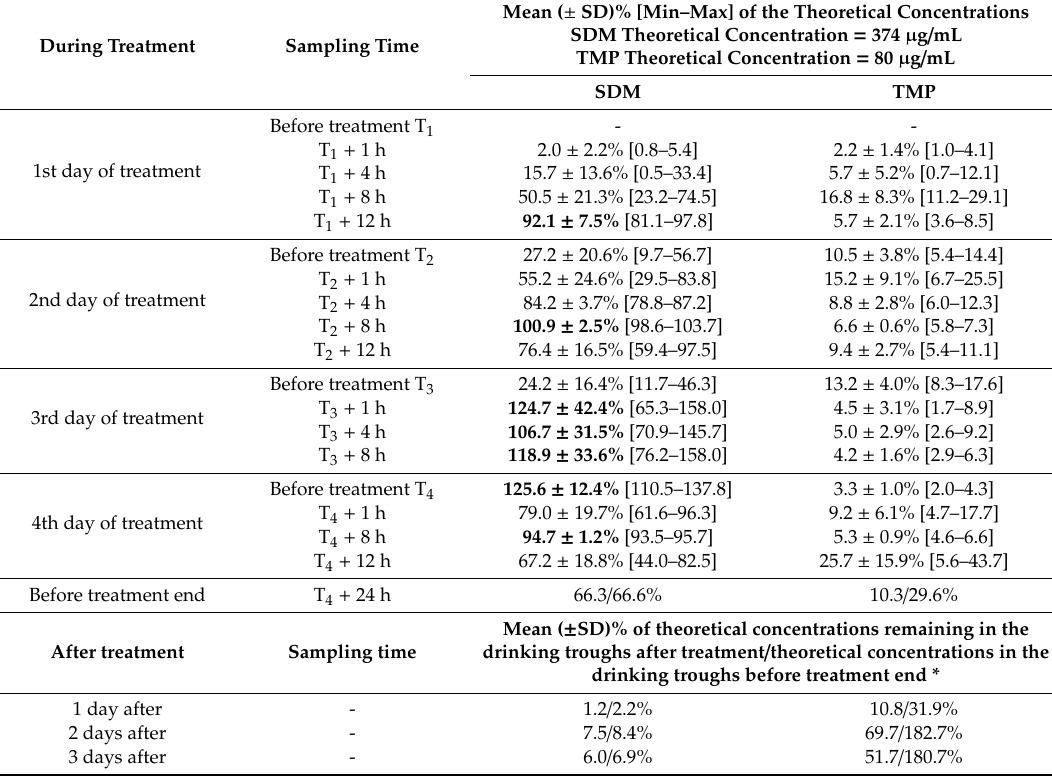
Table 3. Percentage of the theoretical concentrations of SDM and TMP (mean ± SD and [range]) found in the drinking troughs before, during and after the SDM-TMP treatment of 200 lambs for 4 days via